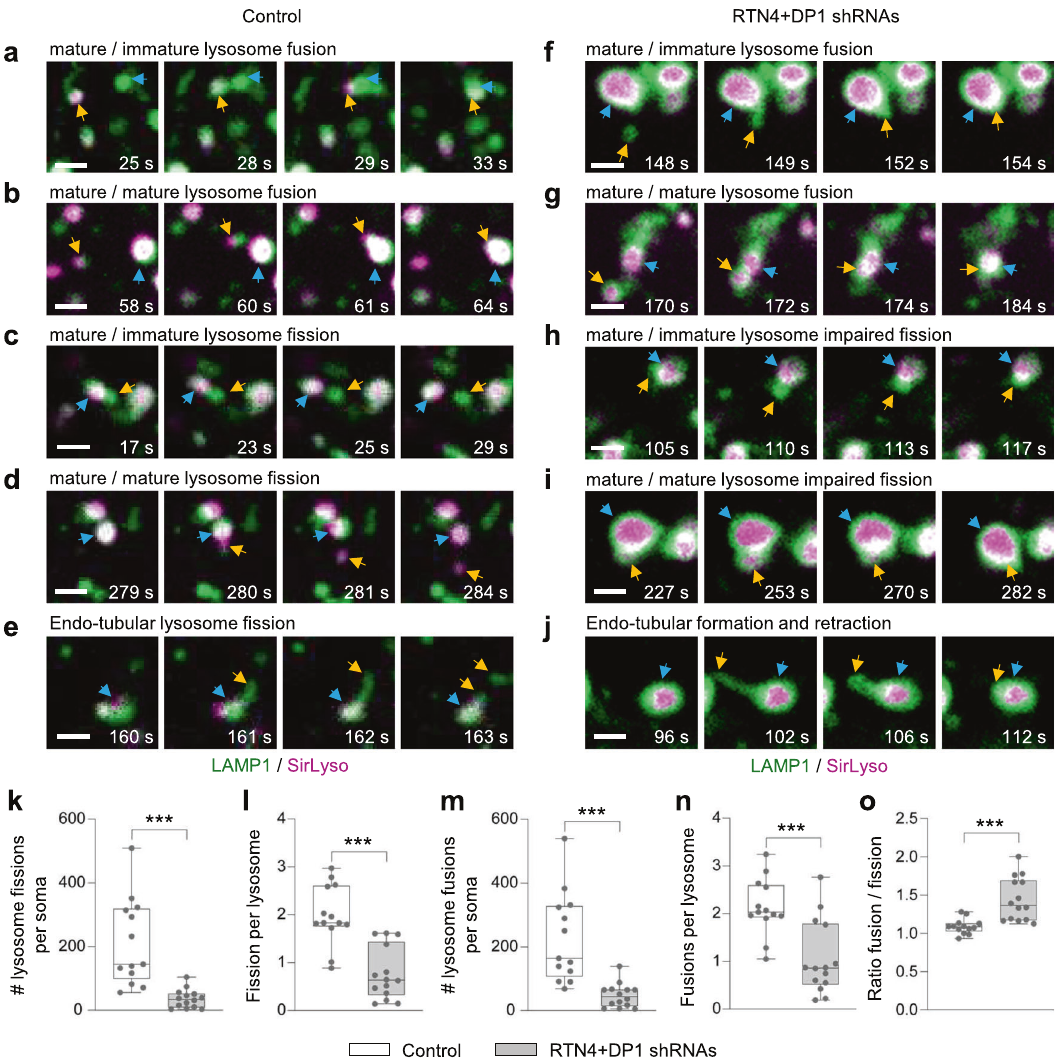
Fig. 4 Enlarged lysosomes are caused by an imbalance in homo- fi ssion. a – j Representative still images of fusion and fi ssion events from DIV7 neurons co-transfected with control pSuper ( a – e ) or shRNAs targeting RTN4 plus DP1 ( f – j ) together with LAMP1-GFP (green) and labeled with SirLyso (magenta) prior imaging for 300 s every 1 s. Fusion between lysosomes in ( a , b , f , g ); Fission in ( c – e ); impaired fi ssion in ( h – j ). Time scale included per event. Blue and orange arrows point to two lysosome undergoing fusion, or one lysosome budding from a parent lysosome. In all images, scale bars represent 1 µ m. See also Supplementary Fig. 4a – h and Supplementary Movie 8. k – o Parameters indicated in each graph were quanti fi ed from live neurons transfected and labeled as in ( a – j ) and imaged for 300 s every 1 s. pSuper control ( n = 13), white bars and RTN4 plus DP1 knockdown ( n = 14), gray bars. Boxplots show 25/75-percentiles, the median, and individual datapoints each represent a neuron. Whiskers represent min to max; ns — not signi fi cant, *** p < 0.001 and ** p < 0.01 comparing conditions to control (two-sided Mann – Whitney U ( k – o ). Source data and exact p values are provided as a Source Data fi